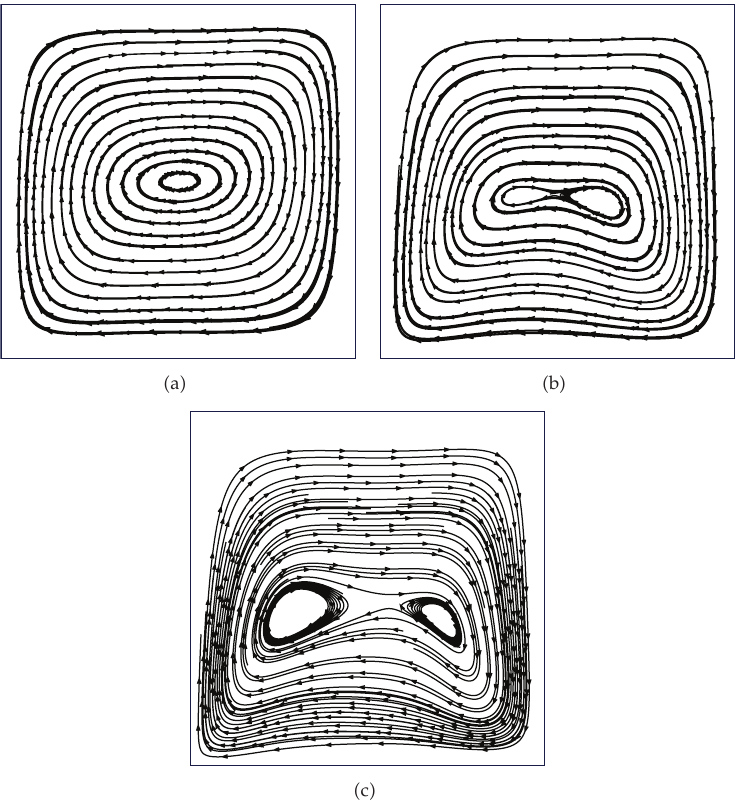
Figure 6: Streamlines for the thermomagnetic flow in a square cavity Δ T (cid:8) 60K, Ra (cid:8) 2 × 10 4 : (cid:3) a (cid:4) m (cid:8) 0 . 0, (cid:3) b (cid:4) m (cid:8) 0 . 05, and (cid:3) c (cid:4) m (cid:8) 0 .